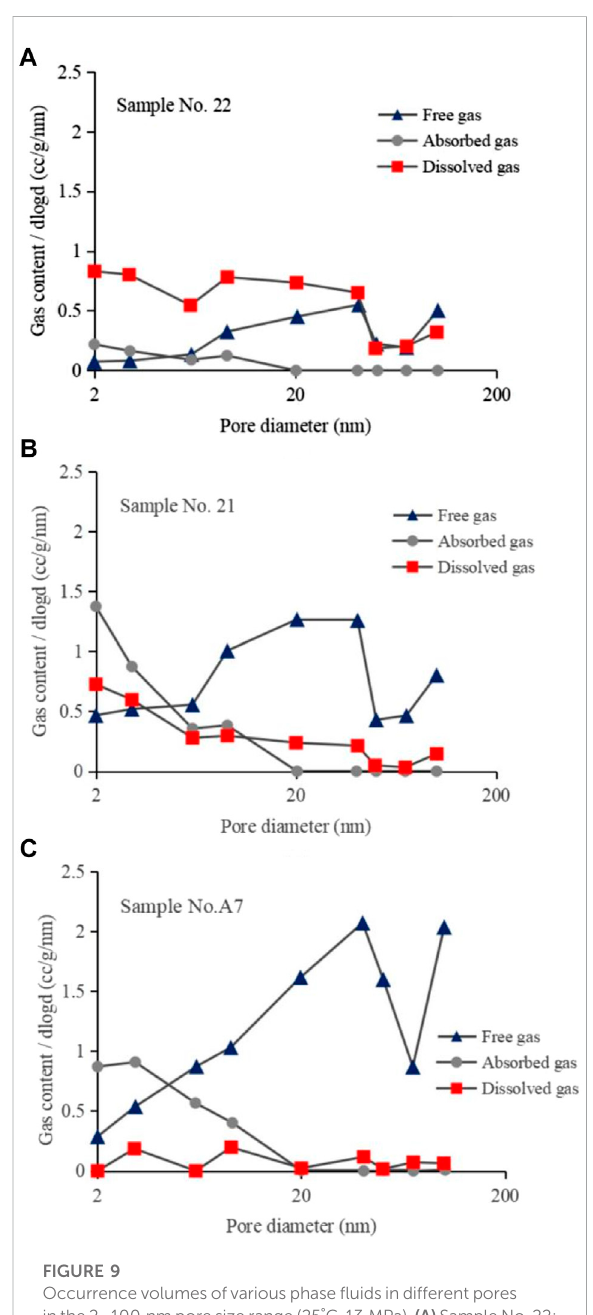
FIGURE 9 Occurrencevolumesofvariousphase fl uidsindifferentpores inthe2 – 100 nmporesizerange(25 ° C,13 MPa). (A) SampleNo.22; (B) Sample No. 21; (C) Sample No.